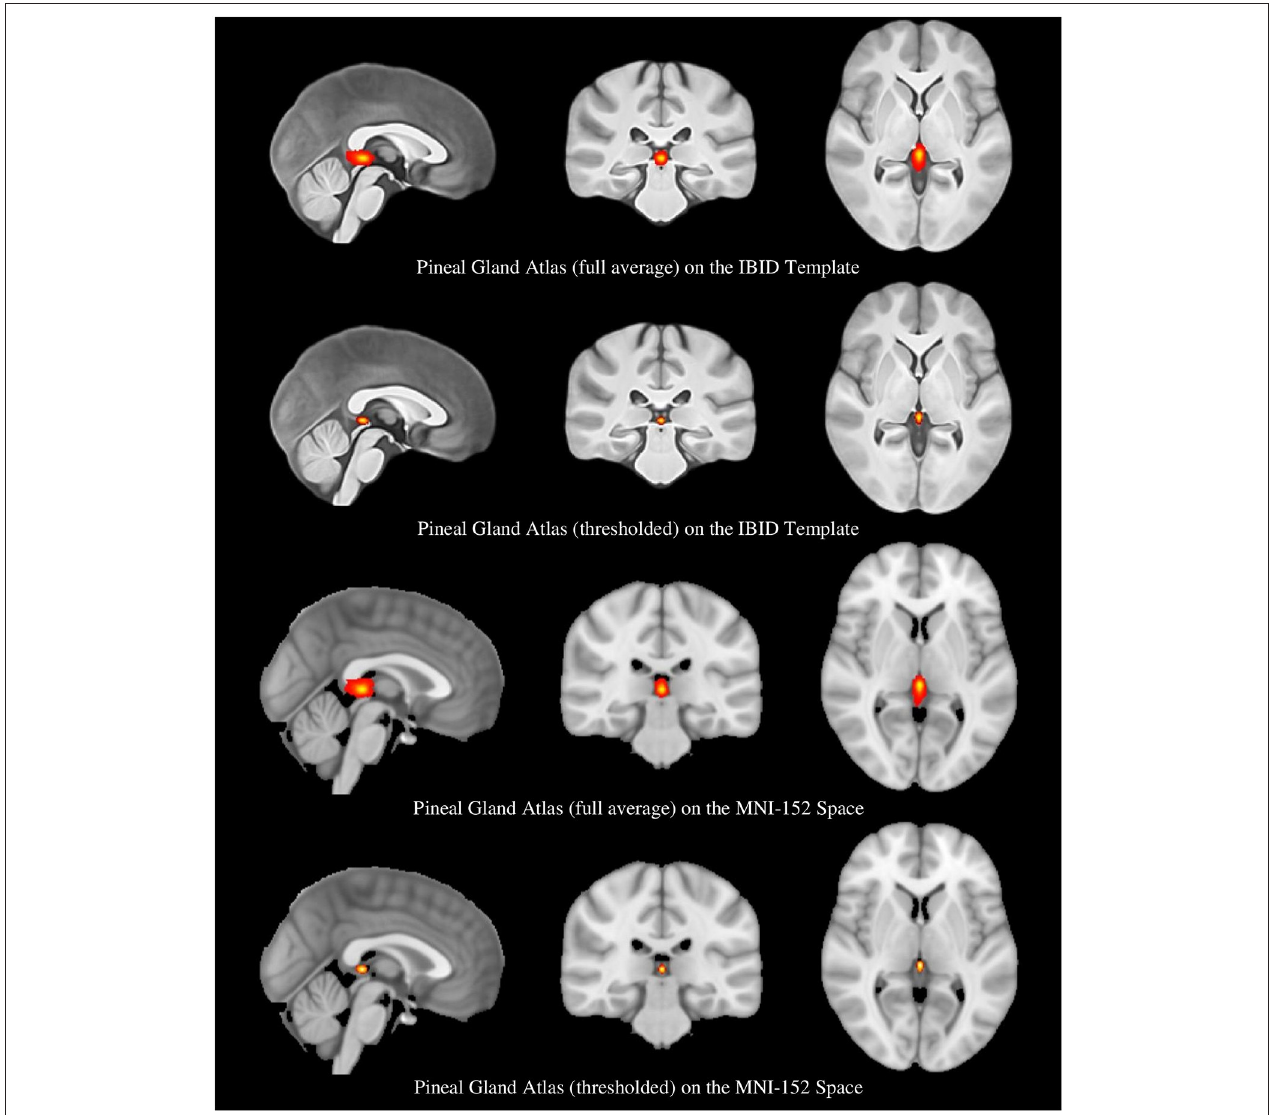
FIGURE 4 | The full average and thresholded PG atlases in the local and MNI